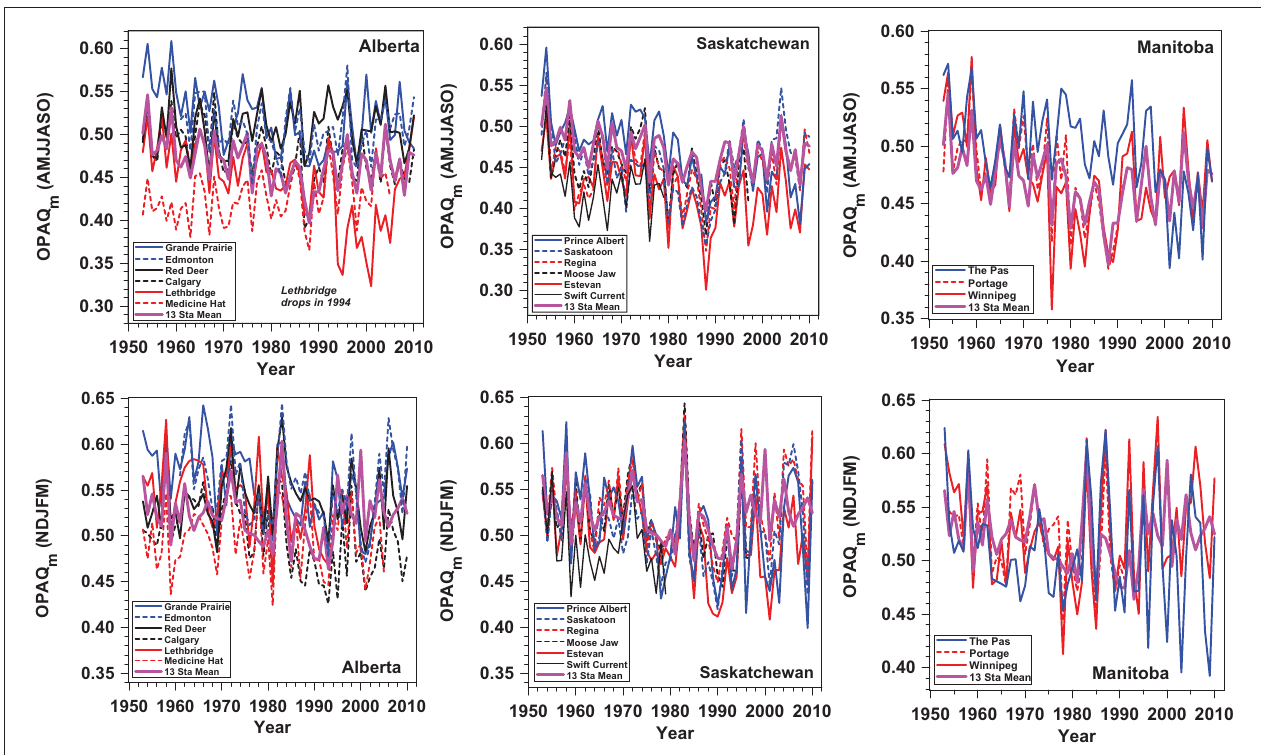
FIGURE 4 | Variation of mean opaque cloud for warm (top) and (bottom) cold seasons, grouped by Provinces, together with a 13-station Prairie mean from 1953 to 2010.